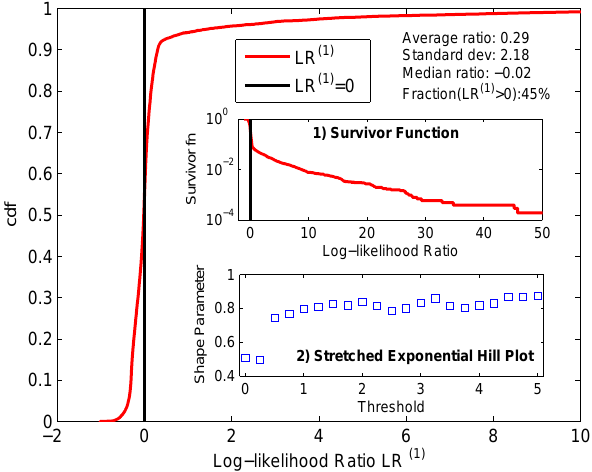
Fig. 7. Cumulative distribution function (cdf) of the individual log- likelihood ratios LR ( 1 ) between log-likelihood scores of the SIR k particle filter and the benchmark. Inset 1: Survivor function. In- set 2: Hill plot of the maximum likelihood estimates of the shape parameter of a stretched exponential distribution as a function of the threshold above which the parameter is